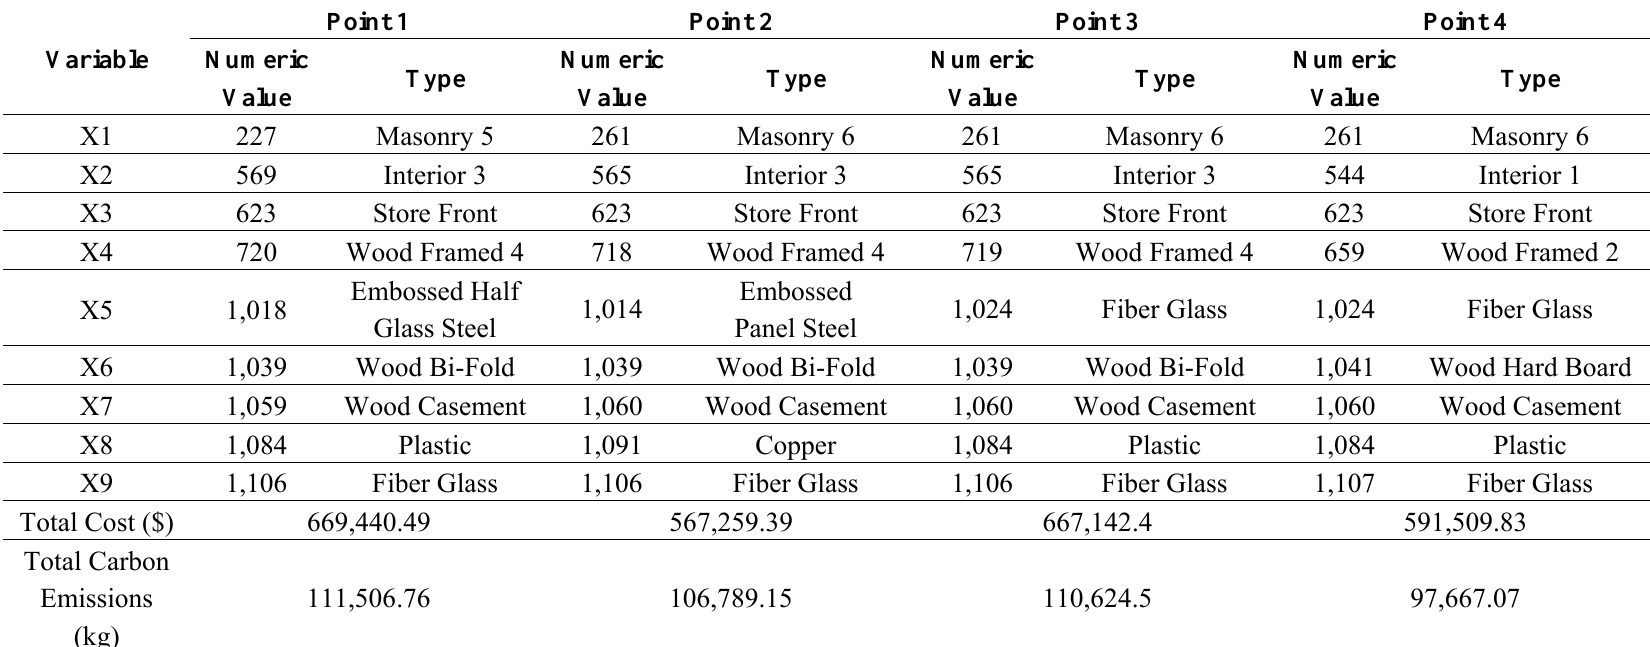
Table 10. Optimal Solutions based on Scenario